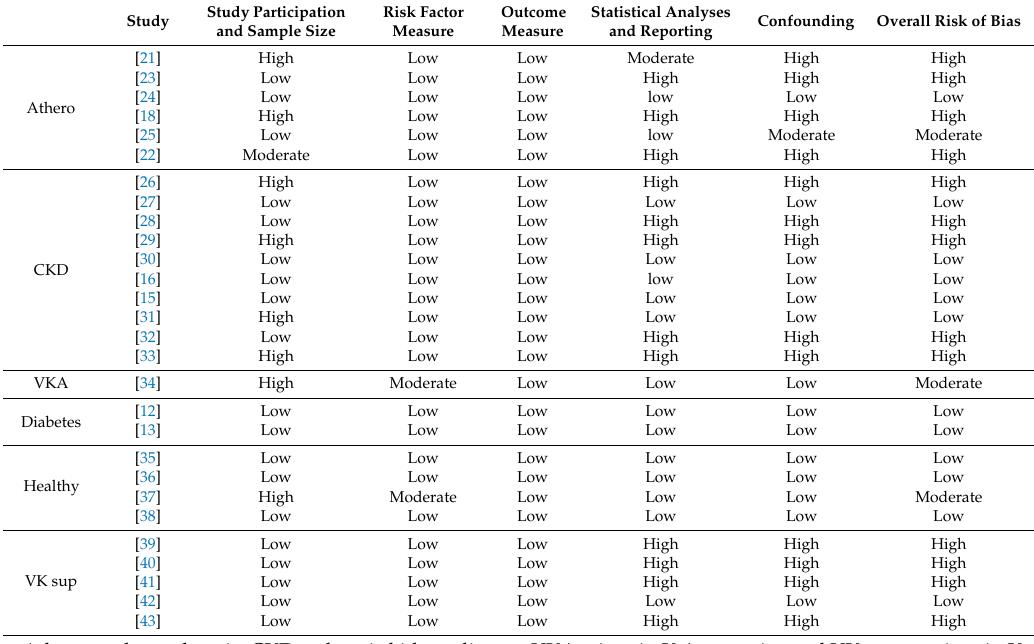
specific disease